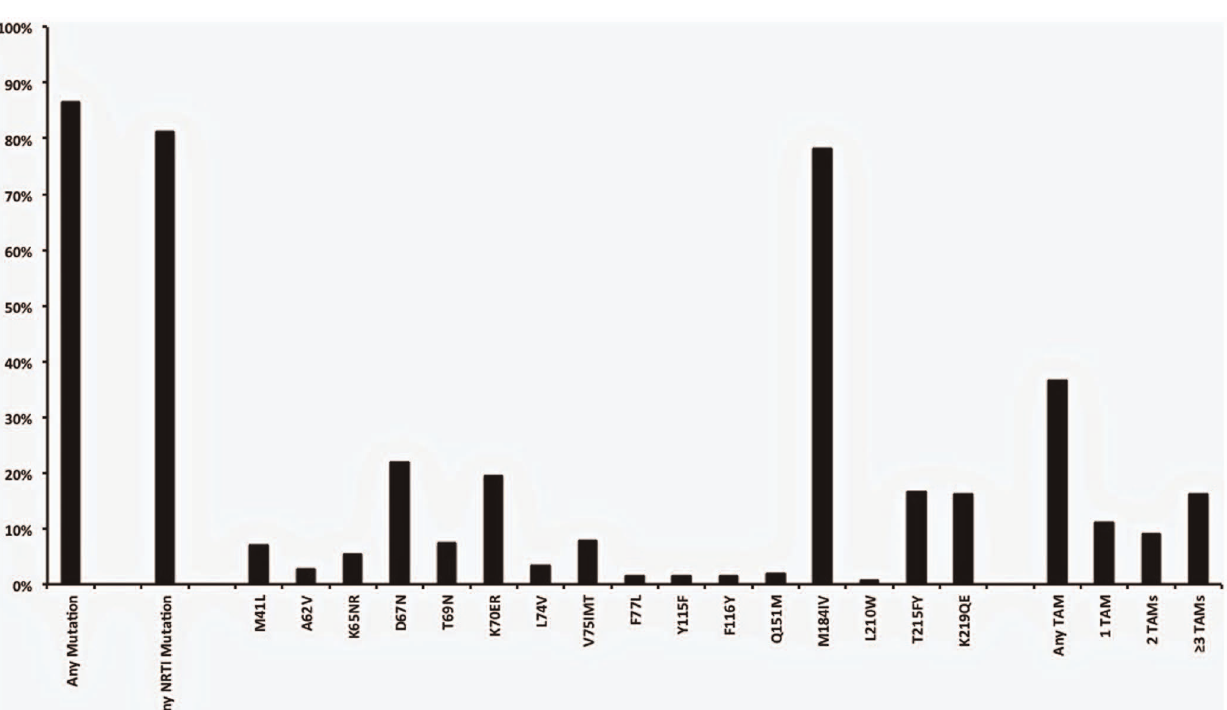
Figure 3. NRTI mutations, including summary of proportion with thymidine analogue mutations (TAMs).